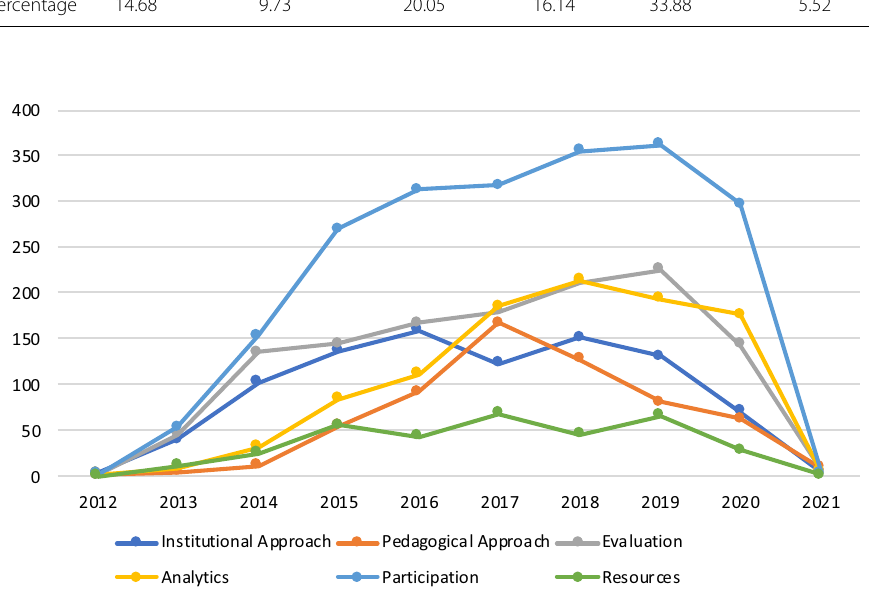
Fig. 9 Thematic cluster temporal